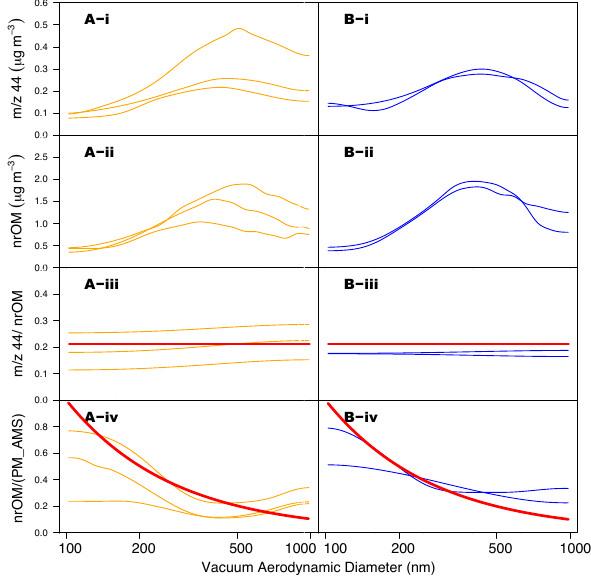
Fig. 9. See list of figure captions. Fig. 8. Daytime profiles of A (“Afternoon High” days) and B Fig. 8. See list of figure captions. Fig. 9. Representative size distributions for A (“Afternoon High” 51 50 (“Noon High” days) for (i) carboxylic acid groups, (ii) the FTIR days) on 12, 16, and 21 September, in time period 14:00–18:00PST combustion factor, and (iii) the AMS combustion factor concentra- and B (“Noon High” days) on 17 and 20 September in time period tion. Colors indicate “Background SOA” (light green) and “Today’s 10:00–14:00PST for (i) m/z 44, (ii) nrOM, (iii) ( m/z 44)/nrOM, and SOA” (dark green), respectively. Red dashed lines in panels A -i (iv) nrOM/PM AMS . The ratios (( m/z 44)/nrOM and nrOM/PM AMS ) and B -i represent average daytime profiles of normalized O 3 . Black were calculated for each size bin then plotted versus particle size. lines in panels A -i and B -i are the average diurnal carboxylic acid The curves are smoothed with the “Boxcar Smoothing” method group profiles corresponding to the two panels shown in Fig. 4 as with 20-point averaging and wavelet de-noising method to reduce indicated by the labels beside the lines. Vertical blue bars in pan- high-frequency noise in the measurements. Red lines are theoretical els A -iii and B -iii show standard deviations of the averaged diurnal models representing (iii) constant with respect to particle diameter cycles. and (iv) inversely proportional to the particle diameter (1/Dp), for comparison to results of Maria et al.